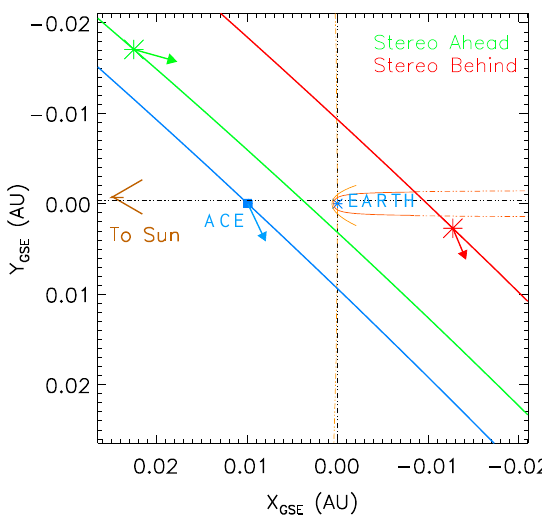
Fig. 2. Position of STEREO-A and B during the event on 27 Febru- ary 2007 in relation to the Earth’s bow-shock and the magneto- sphere (orange lines). The arrows and the lines indicate the ecliptic IMF component and the nominal Parker spiral according to the solar wind speeds observed at both STEREO spacecraft and at